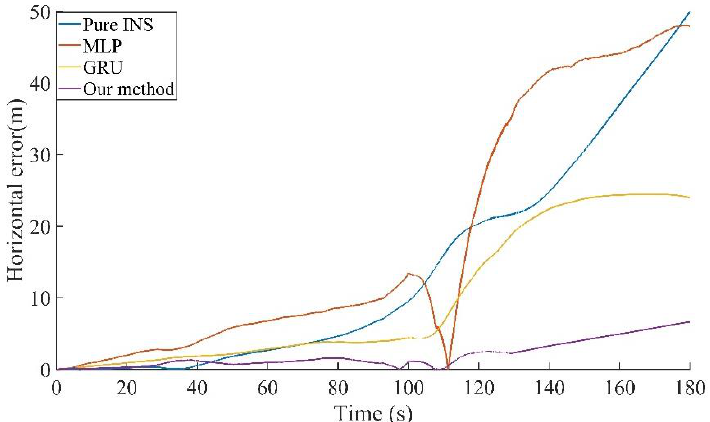
Figure 14. The horizontal position error result of 180 s outage of Experiment 1.